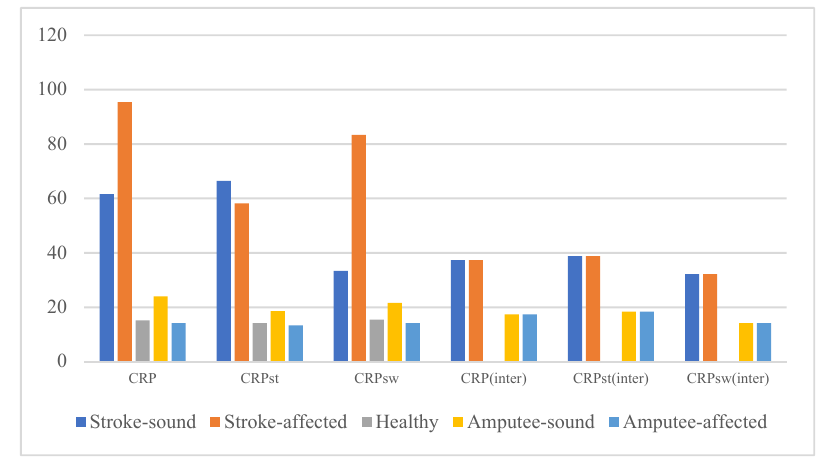
Figure 2. RMSEs of the interlimb and intralimb CRPs of different subjects. Table 3. Stepwise regression